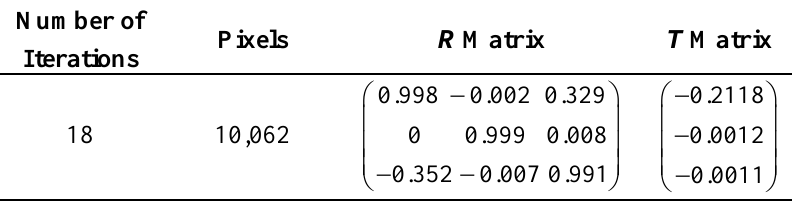
Table 2. Point Cloud Registration